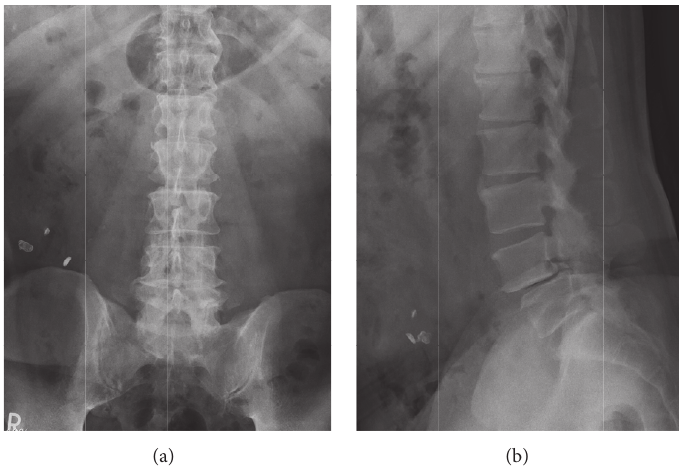
Figure 1: Preoperative radiography of the lumbar spine. Anteroposterior (AP) view (a); lateral view (b). Ossification of the yellow ligament (OYL) is seen at L3/4 and anterior spondylolisthesis of L4 vertebra, with concomitant ossification of the posterior longitudinal